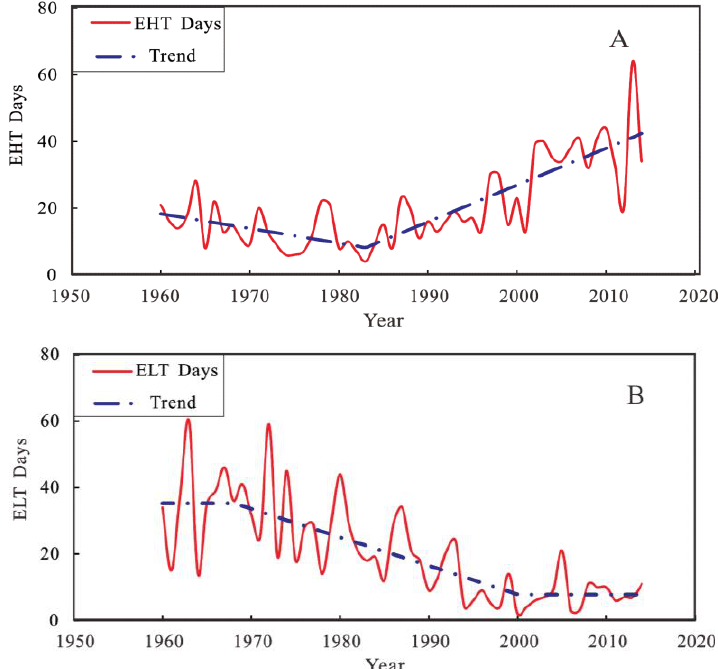
Figure 9. Trend of the frequency of annual: ( A ) Extreme high temperature (EHT) events; ( B ) Extreme low temperature (ELT) events.